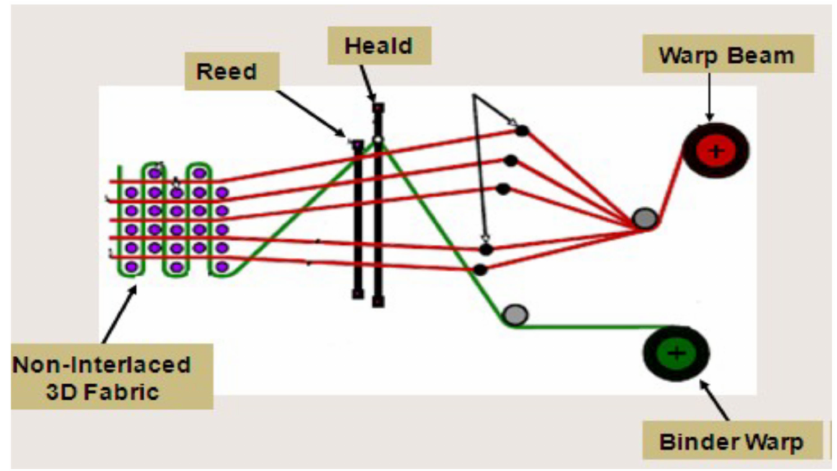
Figure 1. Principle of 3D weaving on a 2D weaving machine. The weaving machine parameters are given in Table